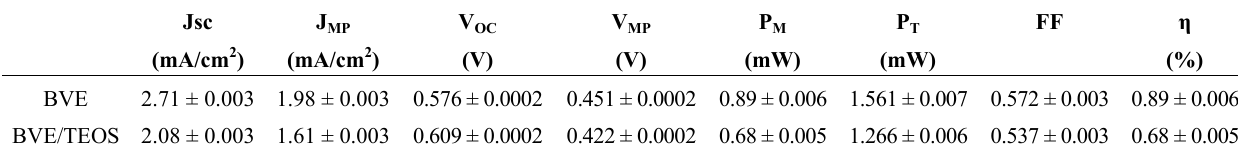
Table 1. Electrical characterization of all prepared solar